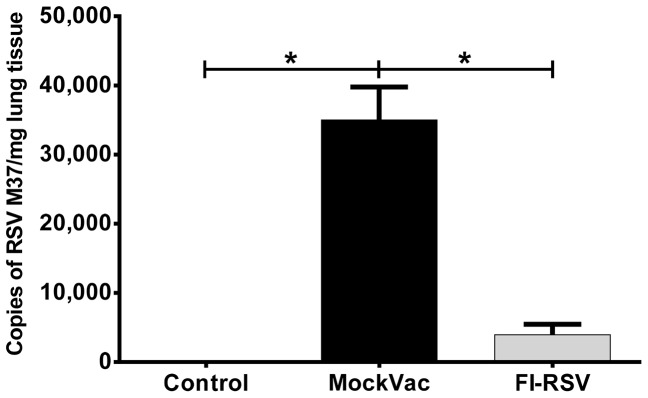
RSV RNA M37 levels in mock-vaccinated (MockVac), FI-RSV-vaccinated, and Control lambs as assessed by RT-qPCR.FI-RSV-vaccinated lambs had significantly less RSV M37 RNA compared to mock-vaccinated lambs. Control lambs lacked RSV RNA RT-qPCR signal. Control n = 4; MockVac n = 4; FI-RSV n = 4. Error bars = SEM, *P<0.05.